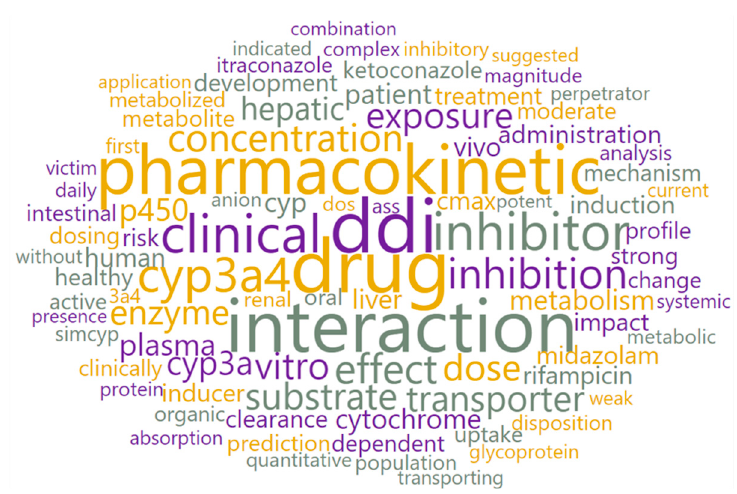
Figure 15. Word cloud for topic